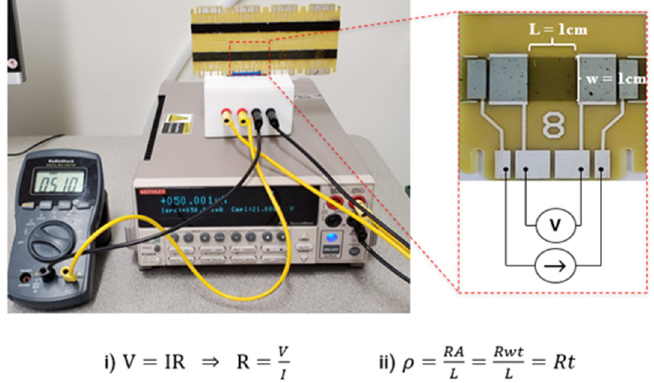
Figure 2. Experimental setup for measure electrical resistivity and governing equations.